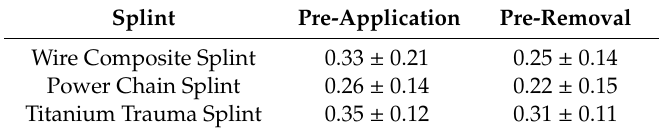
Table 7. Approximal Plaque Index (API)values pre-application and pre-removal of the splints.